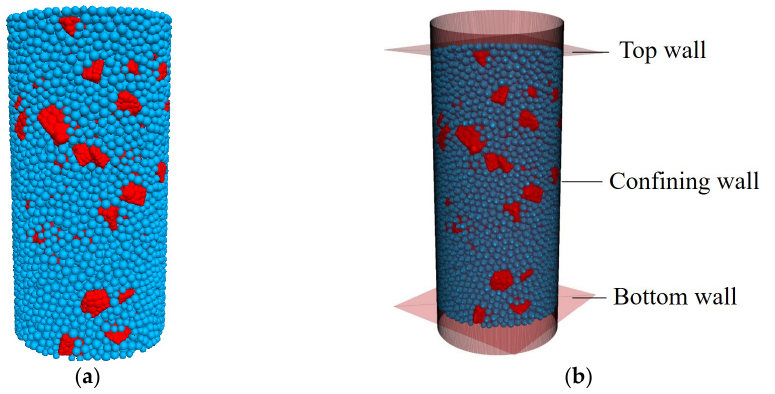
Figure 10. ( a ) Numerical model based on real aggregates; ( b ) Schematic diagram of loading.